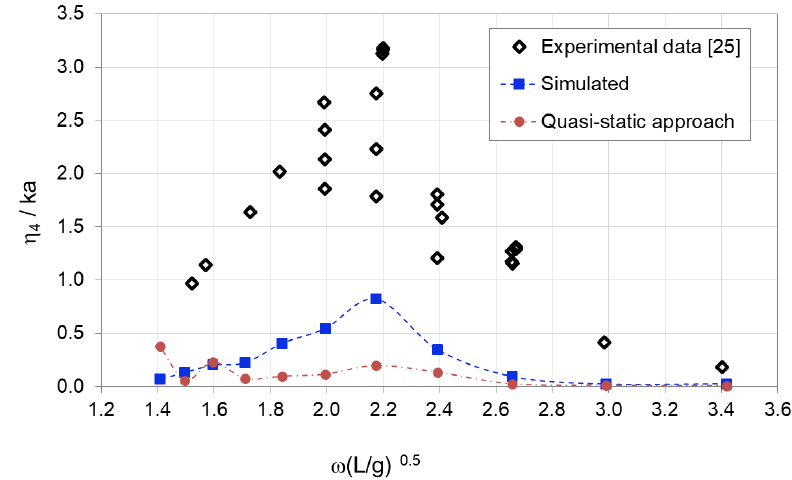
Figure 14. Roll RAO in head sea: comparisons between simulated and experimental